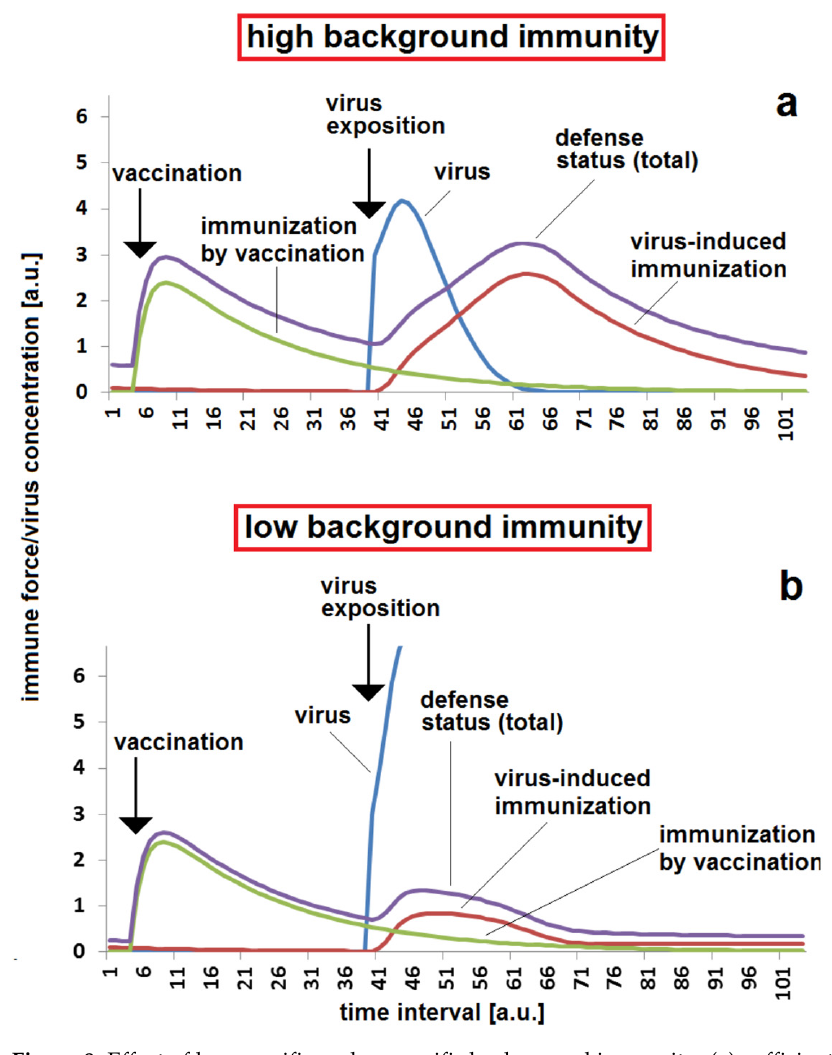
Figure 8. Effect of less specific and unspecific background immunity: ( a ) sufficient protection after a moderate time span between vaccination and virus exposition in the case of moderate unspecific background immunity c BGim = 0.5; ( b ) infection breakthrough in the case of low background immunity, c BGim = 0.15. The same set of other parameters were used for all simulations ( a , b ): k vir = 0.3; k r = 0.12; k st = 0.08; D AB = 0.05; D vacc = 0.4; v oo = 30; st oo = 10. Whereas the concentration of antibodies in the blood can be regarded as a constant parameter (at small time scales) or as a monotonously decreasing parameter (at longer time scales), components of non-specific defense forces might vary with different amplitudes and frequencies over time. These changes can be due to local hyperthermia, physical exhaustion or to additional impacts of other viruses or bacteria, for example. The variations in the resulting total of defense forces are particularly critical if a massive virus exposition takes place in a certain phase of decay of vaccination (Figure 9a). In the lucky case, of a period with more positive elongations of non-specific background immune forces, the viral impact can be fended off quickly, on the one side. However, the same kinetic parameters and the same noise in fluctuations of background immunity can result in a breakthrough infection if the fluctuation drives the immune system in the wrong direction during the critical phase of viral impact (Figure 9c). These critical effects of fluctuation of background immunity should be taken into account in a decision regarding the proper time for a second or third